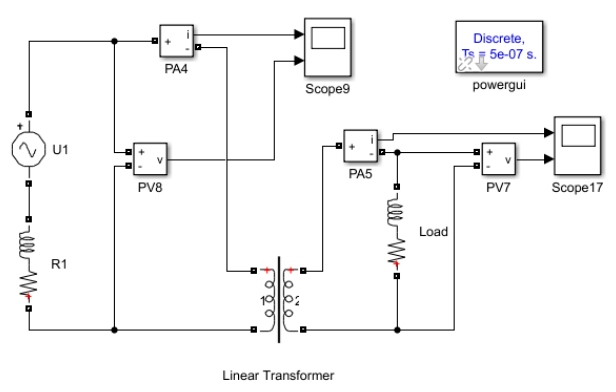
Figure 1. Simulink model of the single-phase classical transformer.